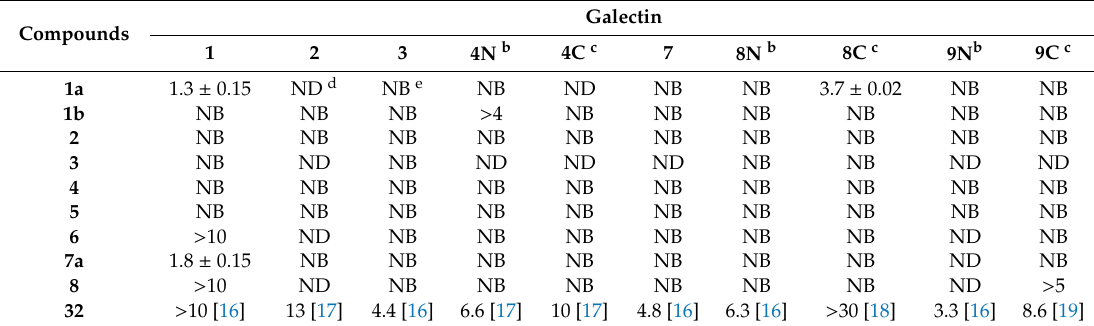
Table 1. K d -values (mM) a of compounds 1a – 1b , 2 – 3 , 7a , 8 , and the reference methyl β - d -galactopyranoside 32 against human galectin-1, 2, 3, 4N, 4C, 7, 8N, 8C, 9N, and 9C in a competitive fluorescence polarization assay